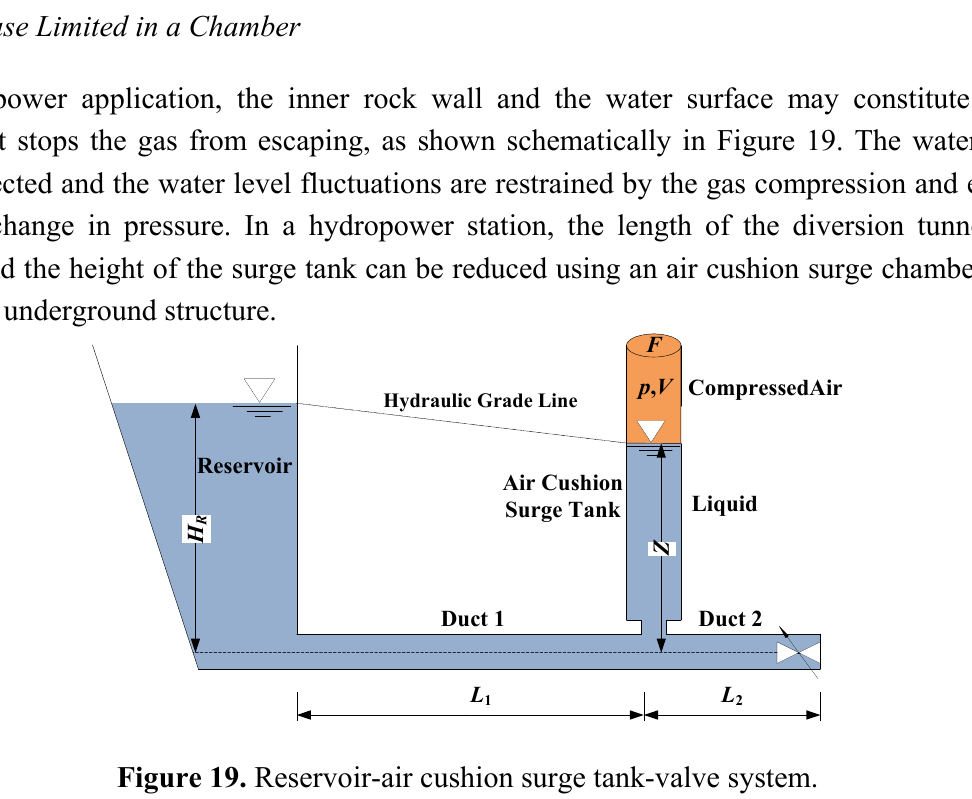
Figure 18. Water level traces when considering friction.